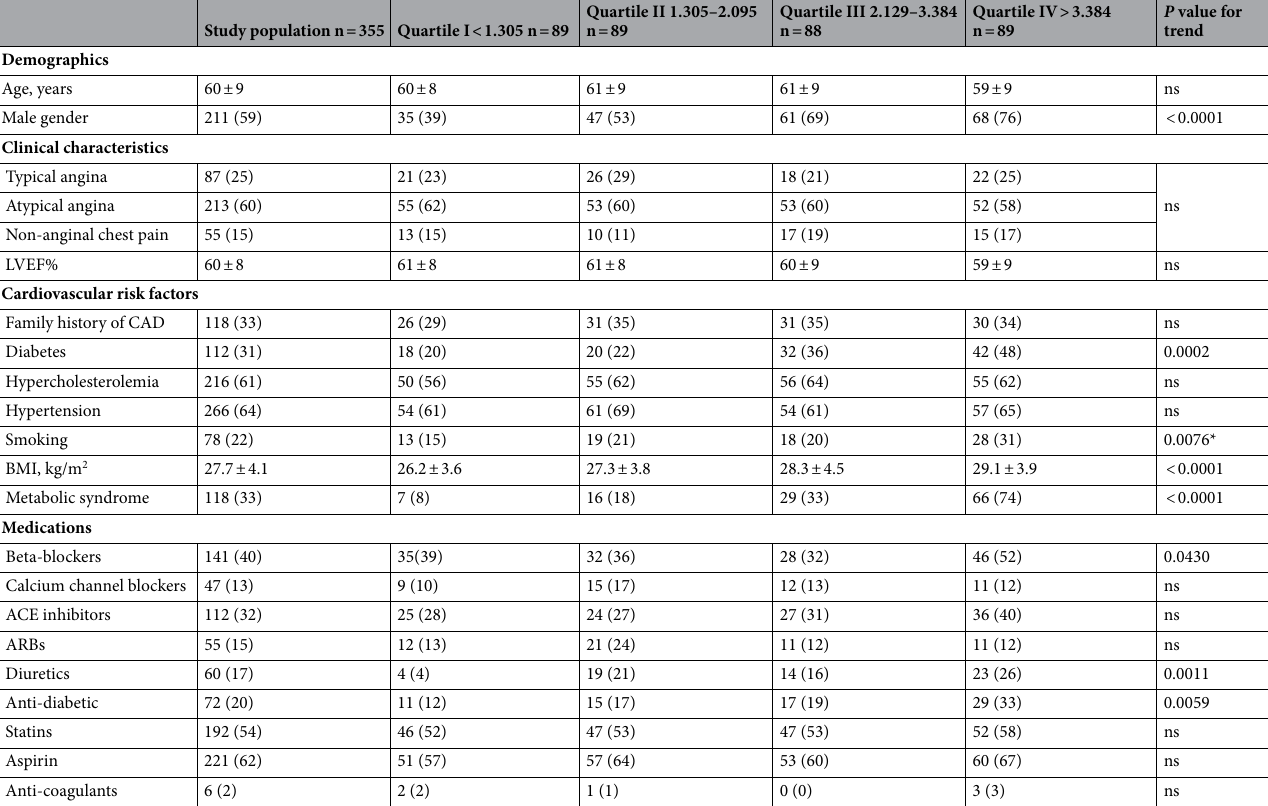
Table 1. Clinical characteristics of the study population and of groups defined by TG/HDL-C quartiles. [Continuous variables are presented as mean ± standard deviation, categorical variables as absolute N and (%); * = P value only for comparison of Quartile IV vs. Quartile